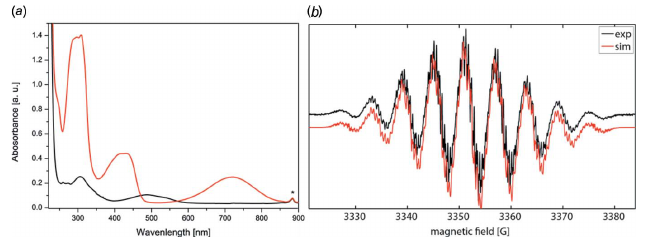
Figure 4 ( a ) UV–Vis spectra of 1 (black line, 2.3 m M , DCM) and 2 (red line, 11 m M , DCM). ( b ) EPR spectrum of 2 in degassed deuterated DCM (black line) along with its simulation (red line) obtained using the program EasySpin (Stoll & Schweiger, 2006).